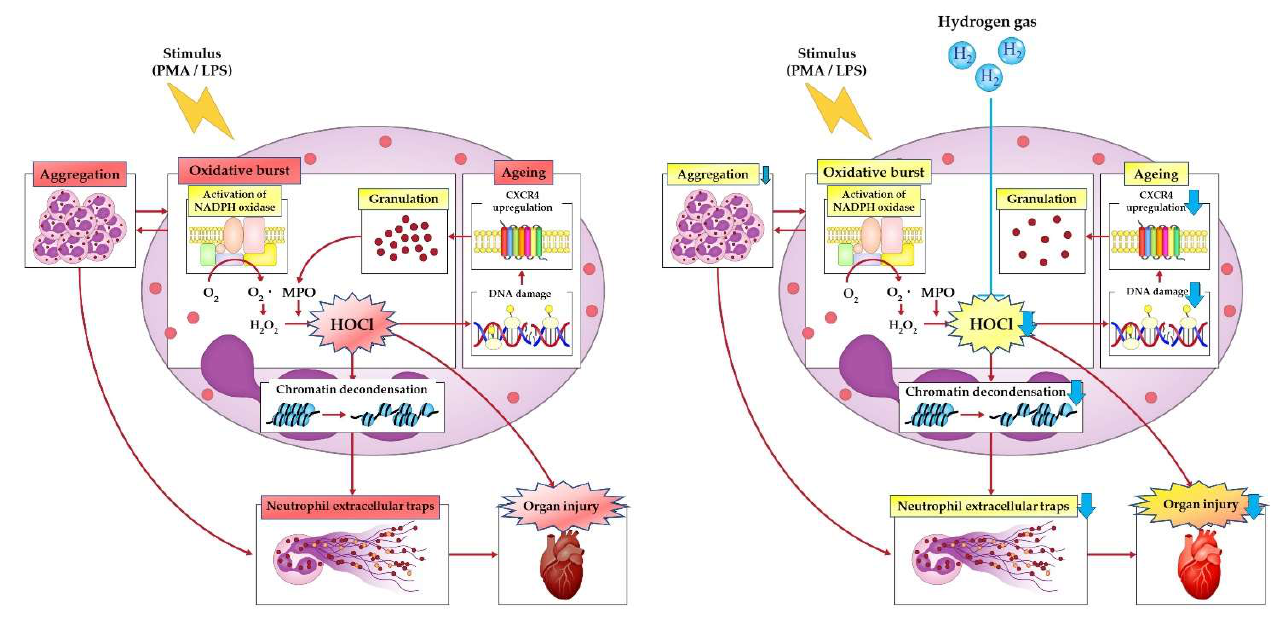
Figure 3. Hydrogen gas causes reduced neutrophil aggregation. Hydrogen gas-mediated neutraliza- tion of hypochlorous acid that is produced by the oxidative burst suppresses DNA damage, which is followed by a decrease in CXC chemokine receptor 4 expression on neutrophils. Maintaining the proper disarming process with hydrogen gas leads to reduced citrullination of histones and decreased release of neutrophil extracellular trap (NET) components, making hydrogen gas therapy a potential therapeutic strategy for cardiovascular disease that involves neutrophil inflammation and NET formation. CXCR4, CXC chemokine receptor 4; H 2 O 2 , hydrogen peroxide; HOCl, hypochlorous acid; LPS, lipopolysaccharide; MPO, myeloperoxidase; NADPH, nicotinamide adenine dinucleotide phosphate; PMA, phorbol-12-myristate-13acetate.